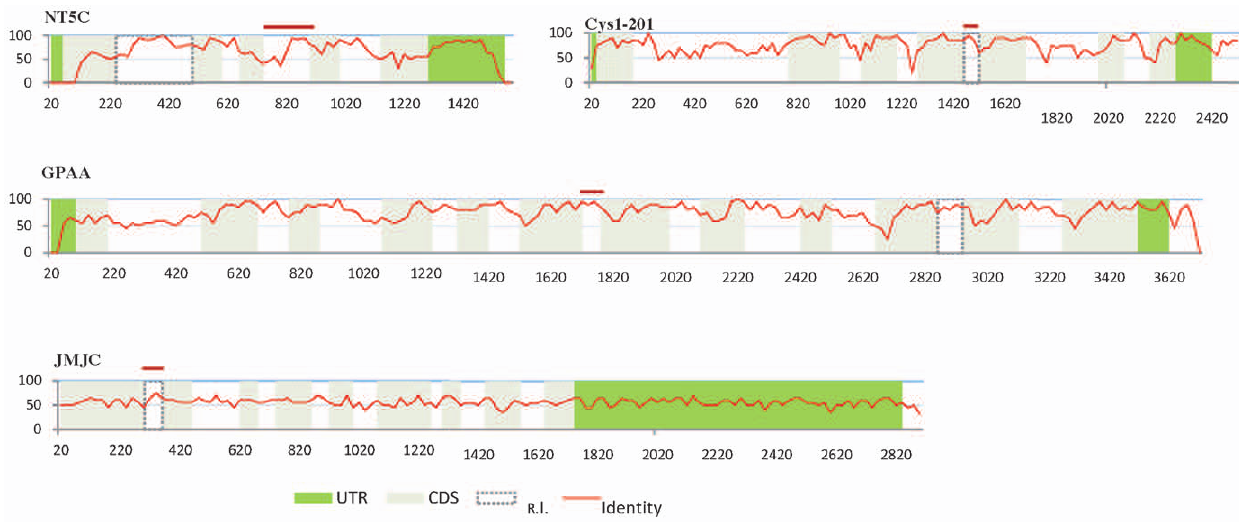
Figure 3. Percentage of identity in a window of 20 nucleotides of five pairs of AS-NMD candidates orthologs between human and mouse. The red bar above each graph represents the retained intron in the mouse AS-NMD candidate (IR = retained intron in the human genome).